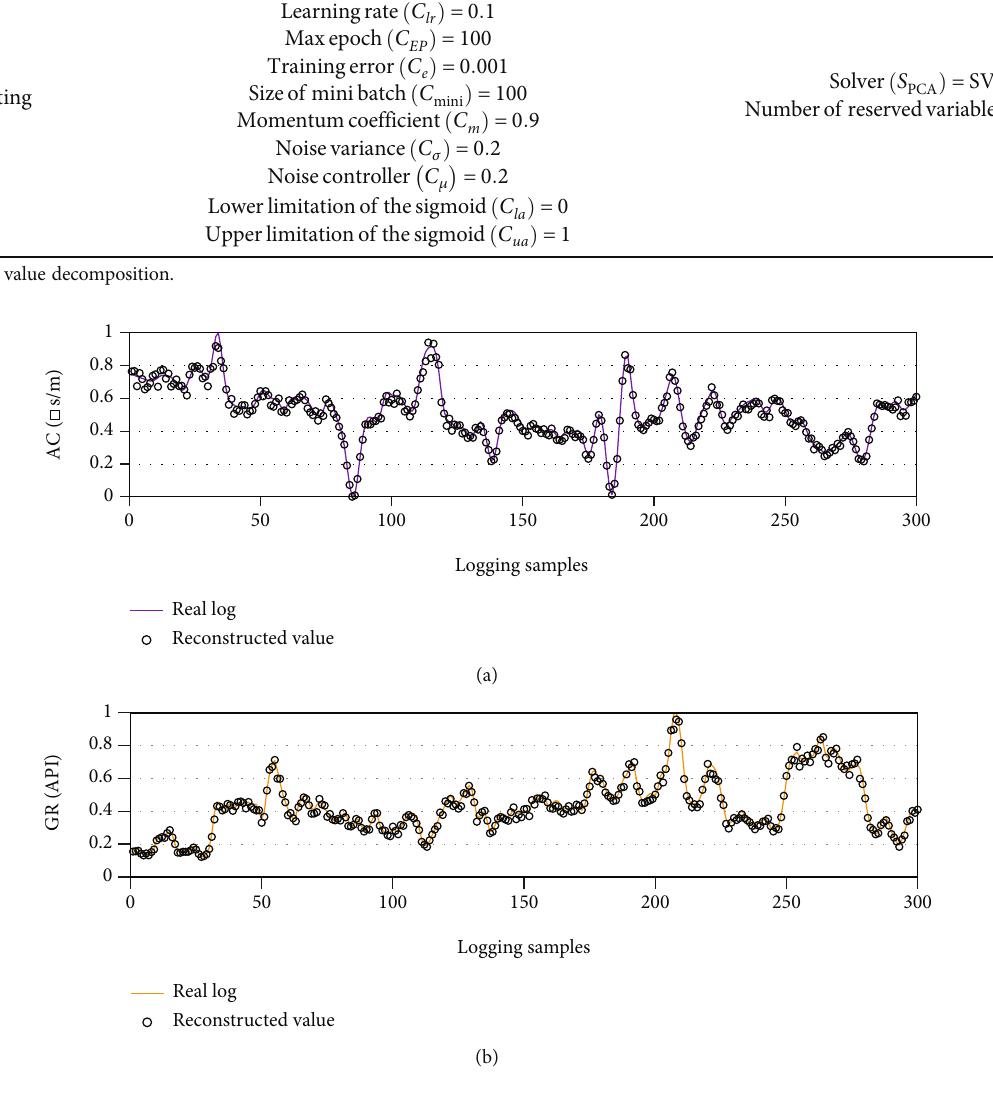
Figure 5: Reconstructions of AC (a) and GR (b) implemented by continuous restricted Boltzmann machine (CRBM). AC =acoustic log; GR=gamma